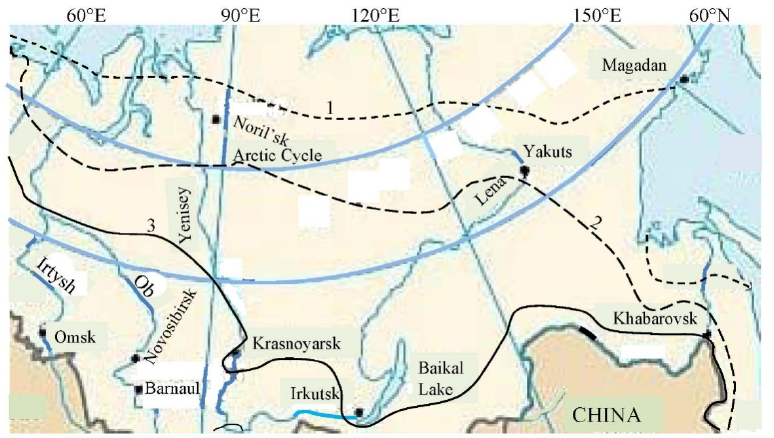
Figure 4. Map of the average annual duration of thunderstorms. North of curves 1, 2 and 3 the duration is up to 10, 20 and 40 hours, respectively. South of curve 3 the duration may reach 60 hours [47–49].